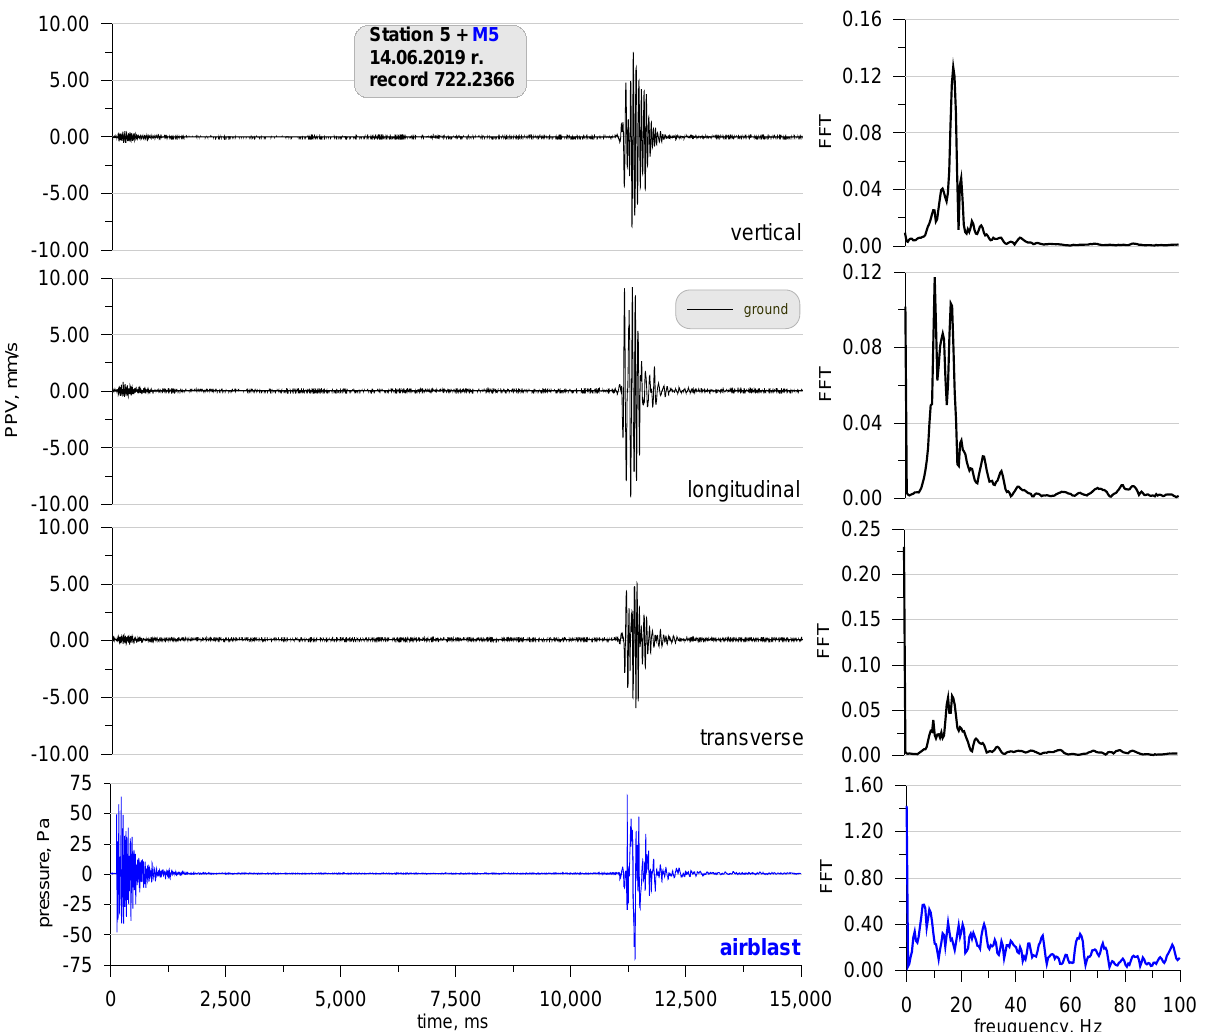
Figure 15. Ground vibration seismogram (three directional components) and recording of airblast wave pressure combined with the analysis of the FFT-Station 5.